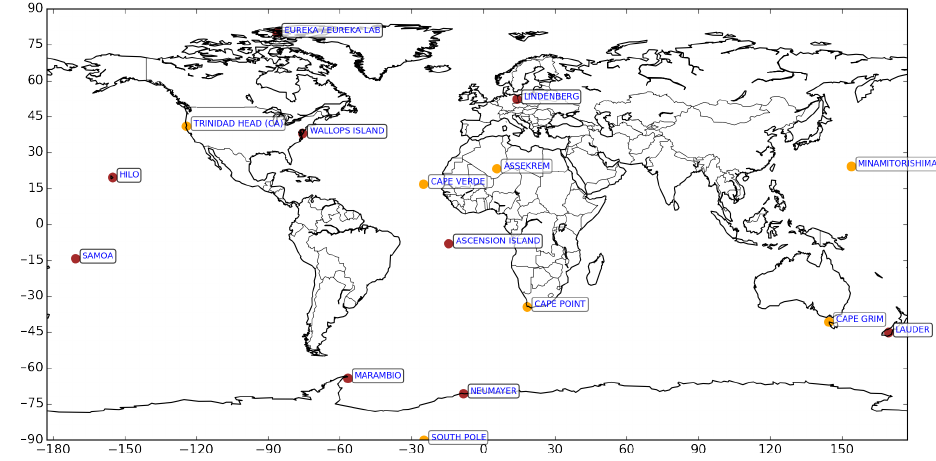
Figure 21. Locations of O 3 observations the model is compared against. Observations made by O 3 sonde are shown in brown; surface observations at GAW sites are shown in gold. Where a site is a location of both sonde release and surface O 3 observation it is shown in brown (Samoa, Neumayer, Lauder, and